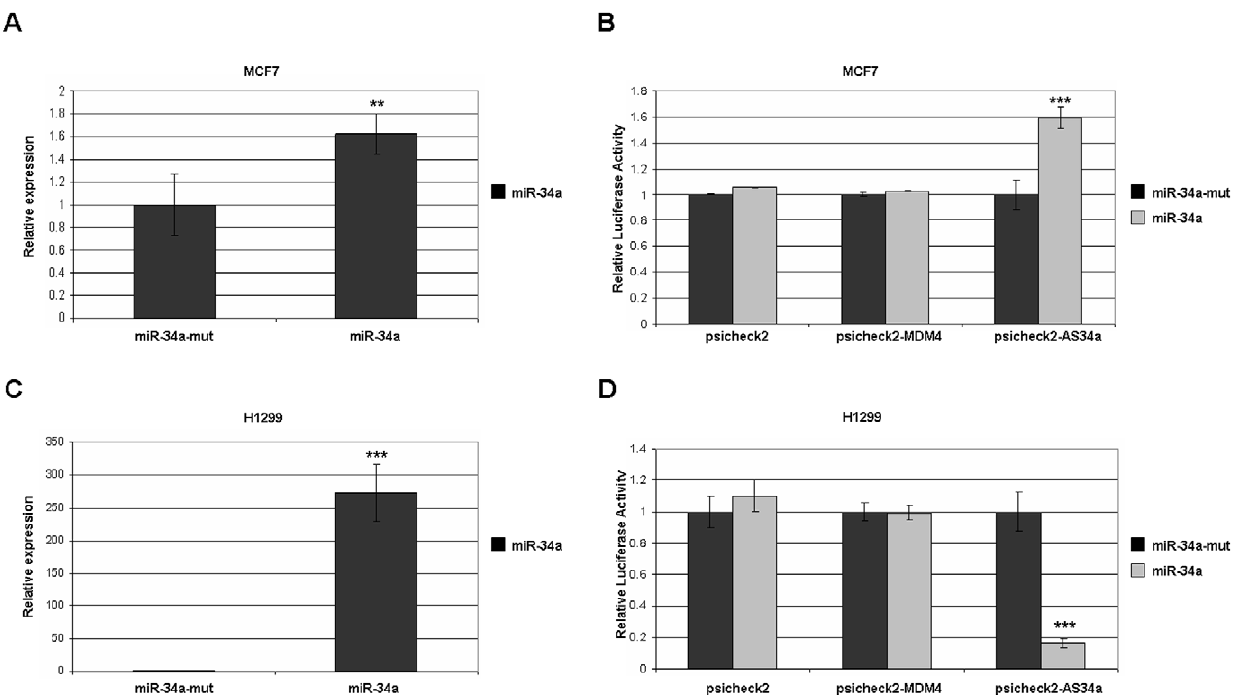
Figure 3. The 3 9 UTR of MDM4 is unresponsive to miR-34a expression. Data are the averages of at least four independent experiments, with standard deviation indicated in error bars. Double asterisks indicate paired, one-tailed t-test values , 0.01 between control and experimental conditions. Triple asterisks indicate p-value , 0.001. (A) MCF7 cells were co-transfected with an expression plasmid for miR-34a or the nonfunctional mutant miR-34a-mut which produces no mature miR-34a transcript [21]. Expression of miR-34a was determined by RT-qPCR. (B) Expression plasmids for miR-34a or miR-34a-mut were co-transfected with a luciferase reporter plasmid containing approximately 1700 bp of the MDM4 3 9 UTR downstream of luciferase. Cell lysates were used for luciferase assays 48 hours after transfection. Expression is relative to the expression of luciferase in the psicheck2 vector lacking a 3 9 UTR. The plasmid psicheck2-AS34a is a positive control for regulation by miR-34a and contains a miR-34a response element [51]. (C and D) As above, for H1299